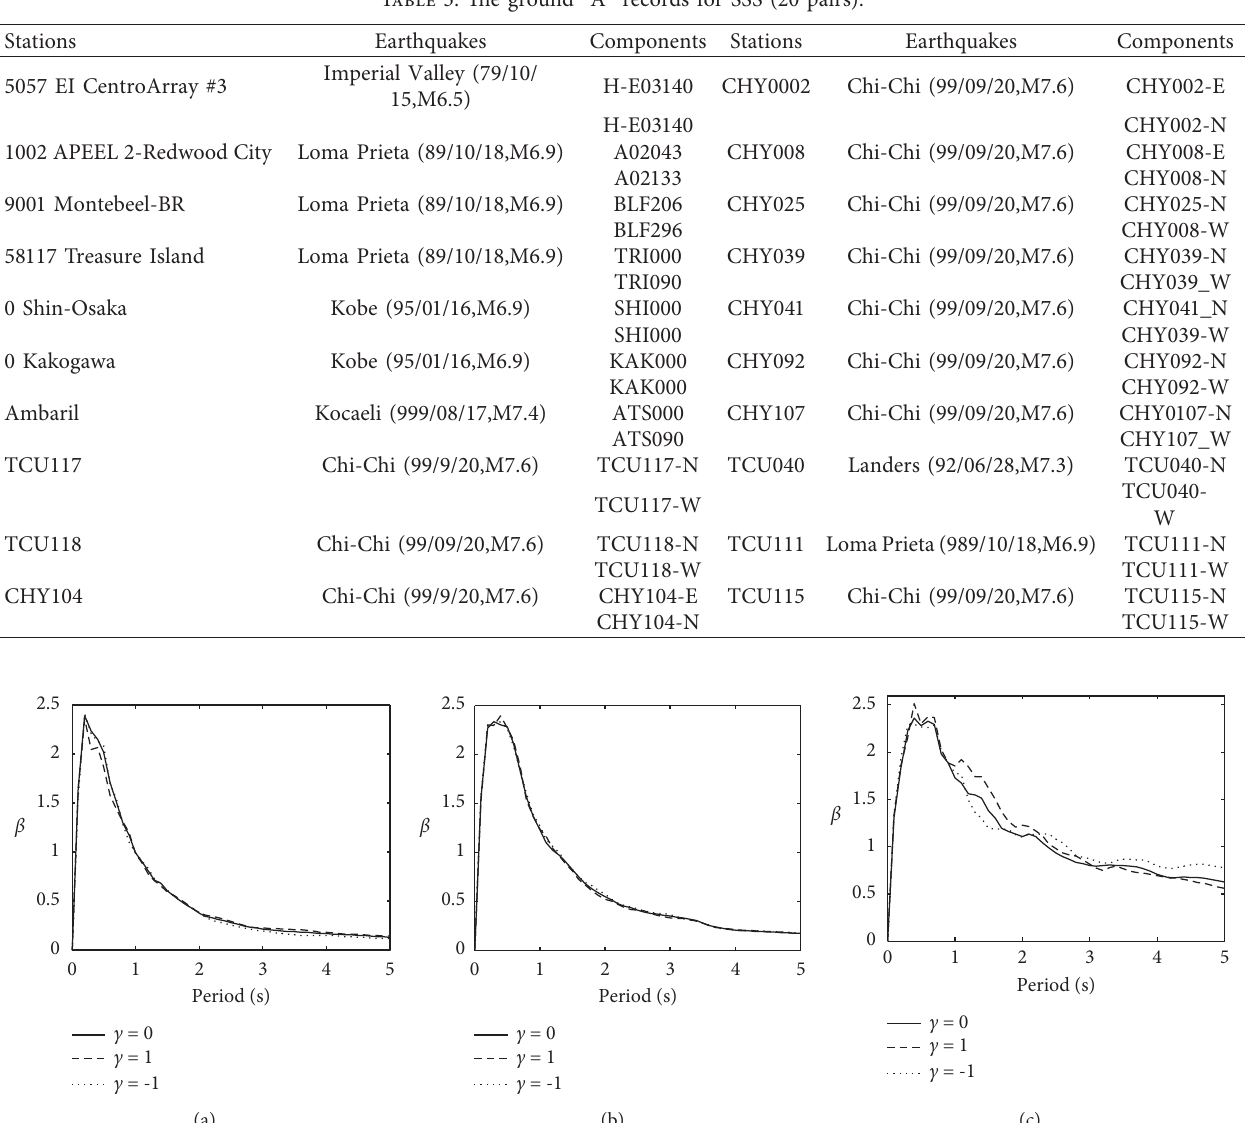
Table 3: The ground “A” records for SSS (20 pairs).